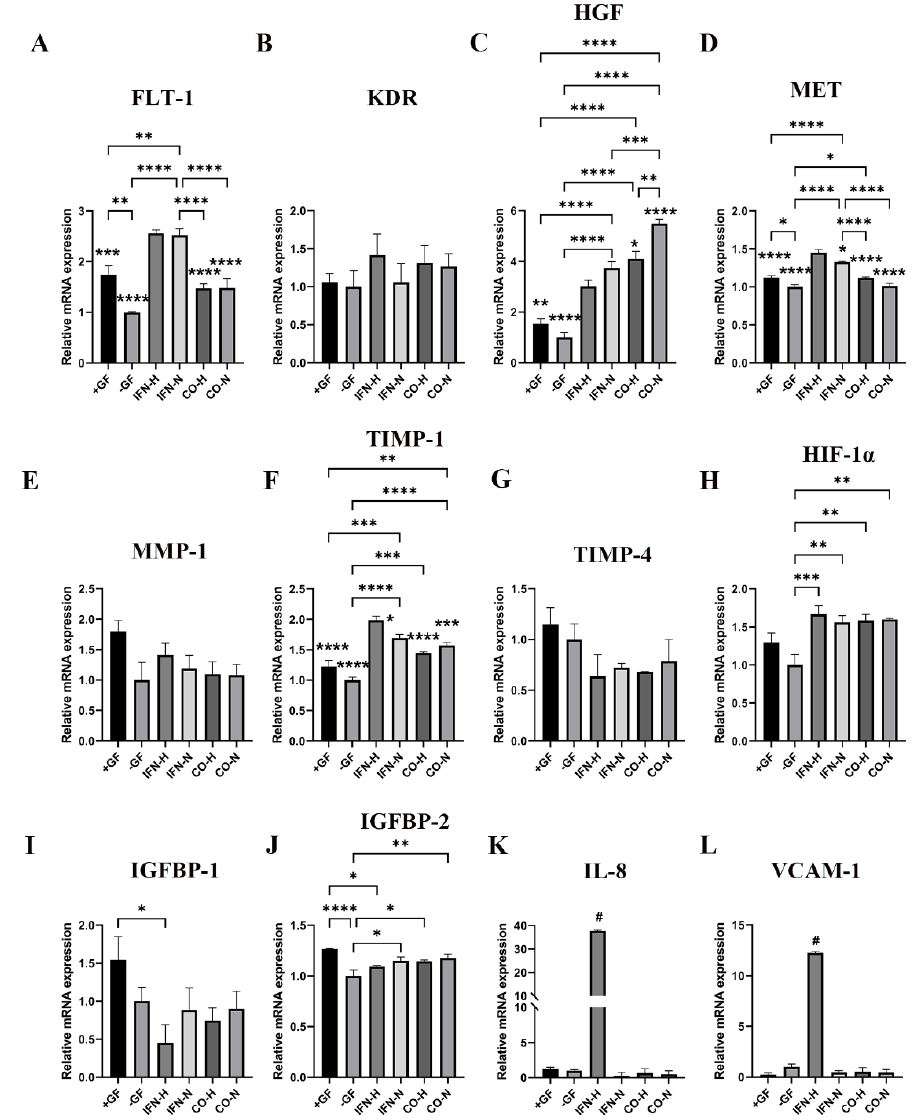
Figure 7. Expression of angiogenesis-related genes by HUVECs cultivated in the presence of pre- conditioned iMSCs secretomes. Gene expression levels of FLT-1 ( A ), KDR ( B ), HGF ( C ), MET ( D ), MMP-1 ( E ), TIMP-1 ( F ), TIMP-4 ( G ), HIF-1 α ( H ), IGFBP-1 ( I ), IGFBP-2 ( J ), IL-8 ( K ), and VCAM-1 ( L ) in HUVECs cultivated in the presence of pre-conditioned iMSCs secretomes. Quantification of mRNA levels was performed using a Thermo Fisher Scientific PCR instrument, and ratios of the target mRNA copy numbers to copy numbers of the housekeeping gene (GAPDH) were calculated in all samples. Mean values ± SEM in HUVECs from different iMSCs secretome groups are displayed as x-fold induction values relative to the negative control group ( − GF). Data were collected from three independent experiments (*, **, ***, **** without bar indicates significant differences compared to the IFN-H group, # indicates that the IFN-H group show significant differences to all other groups, * p < 0.05; ** p < 0.01; *** p < 0.001; **** p < 0.0001).